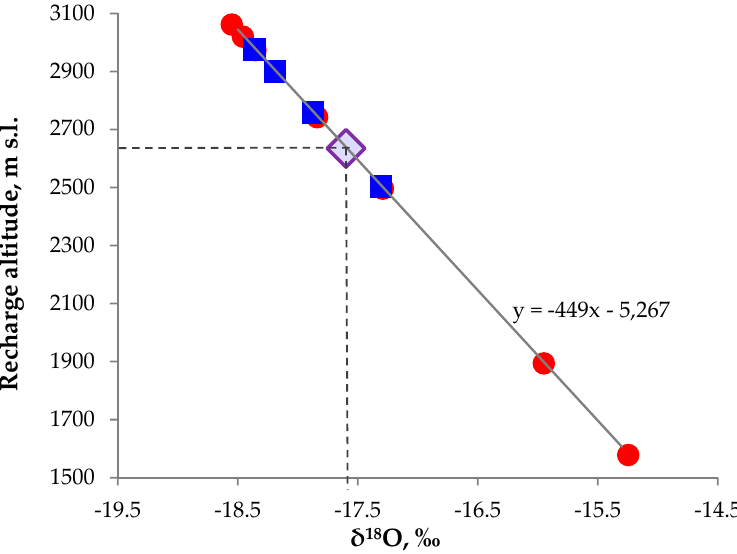
Figure 13. Estimating minimum recharge altitudes of Choygan spring waters. The regression line shows the relationship between altitude and modelled [48] mean δ 18 O of local precipitation. This regression line may be used to estimate an altitude of local recharge from the measured δ 18 O of the Choygan spring waters (red circles = higher temperature thermal waters (Group I); blue squares = lower temperature thermal waters (Group II), purple diamond = average spring water composition). Inferred enrichment of δ 18 O in recharge waters due to evaporative processes means that the values obtained by this method represent minimum recharge altitude estimates.